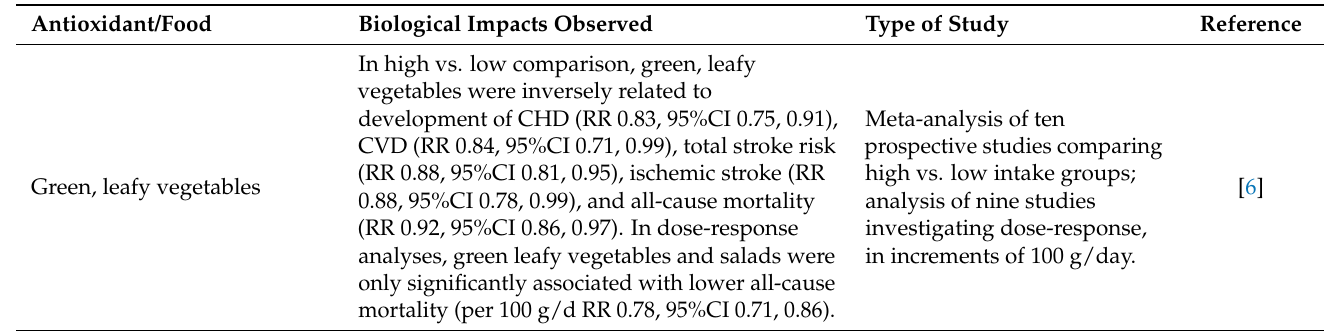
Table 3. Parameters and pertinent results from cited studies examining health outcomes associated with consuming leafy green vegetables. RR = Relative risk, CVD = cardiovascular disease, CHD = coronary heart